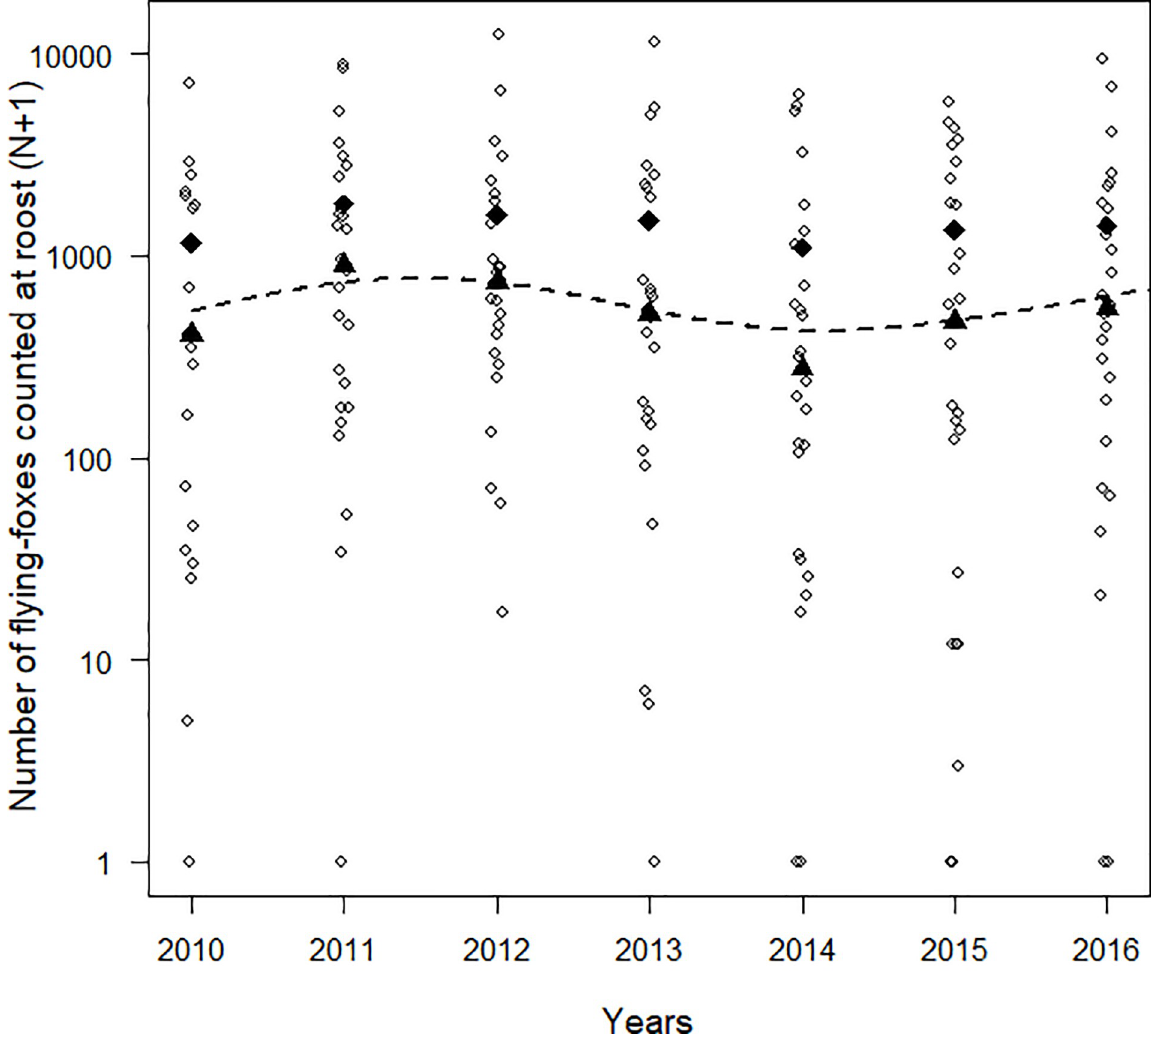
Fig 3. Combined population trends of ornate and Pacific flying-foxes in the Northern Province of New Caledonia from a sample of 30 roosts counted between 2010 and 2016. Annual average and median values are depicted by diamond shapes and triangles respectively. The dotted line refers to the mean predicted value from the GAMM analysis. Note the log 10 -transformed y-axis.